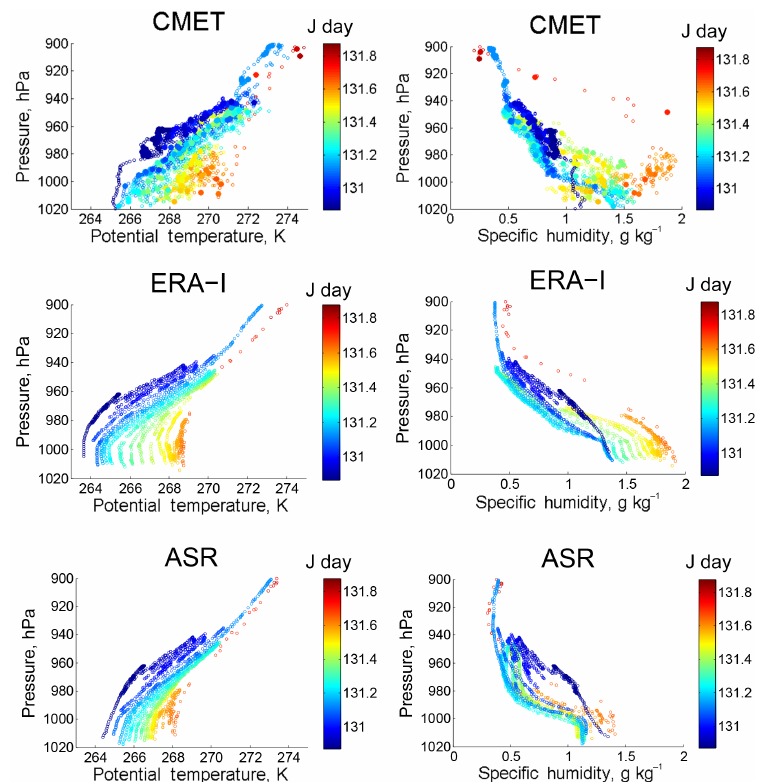
Figure 10. Profiles of potential temperature and specific humidity during flight 5 as observed by the CMET balloon and according to the 4-D interpolated ERA-I and ASR model outputs. CMET measurements made during descents only ( > 0.1ms − 1 vertical descent speed) are shown as filled circles and full data sets are shown as open